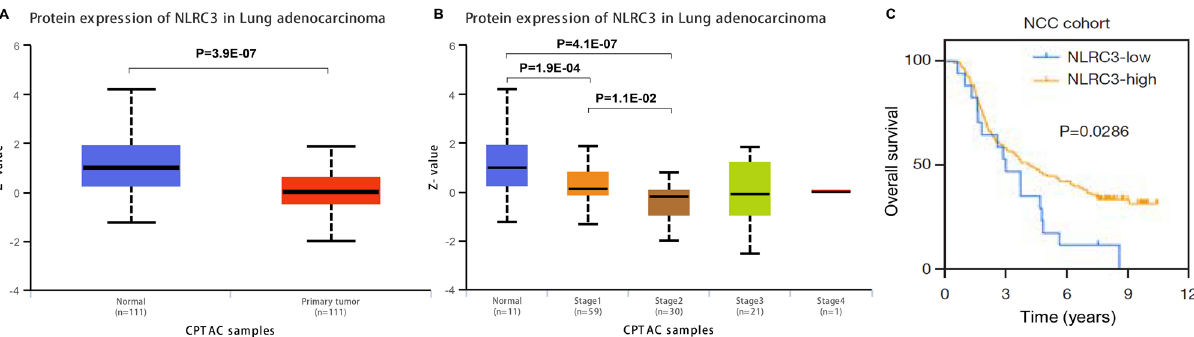
Figure 3. NLRC3 protein expression and prognosis in LUAD. ( A ) The protein expression level of NLRC3 in LUAD and normal tissues using the UALCAN database. ( B ) The association between NLRC3 protein expression and tumor stage in LUAD using the UALCAN database. ( C ) The survival curves for OS of patients with high/ low NLRC3 expression from the National Cancer Center of China (NCC) LUAD cohorts. This figure and the corresponding result were originally published in Wang et al. 9 . Reused with permission from AME Publishing